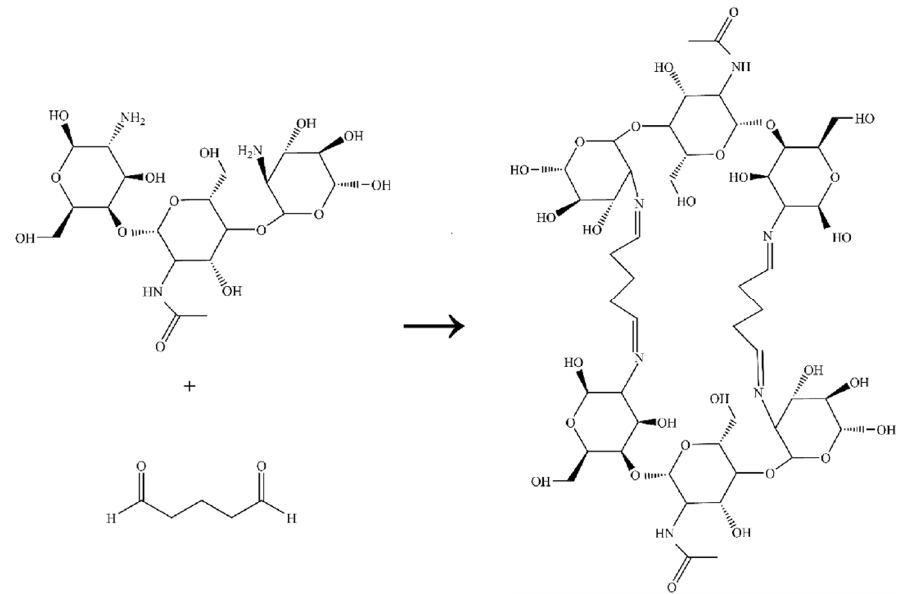
Figure 1. Principle of the glutaraldehyde cross-linking reaction.